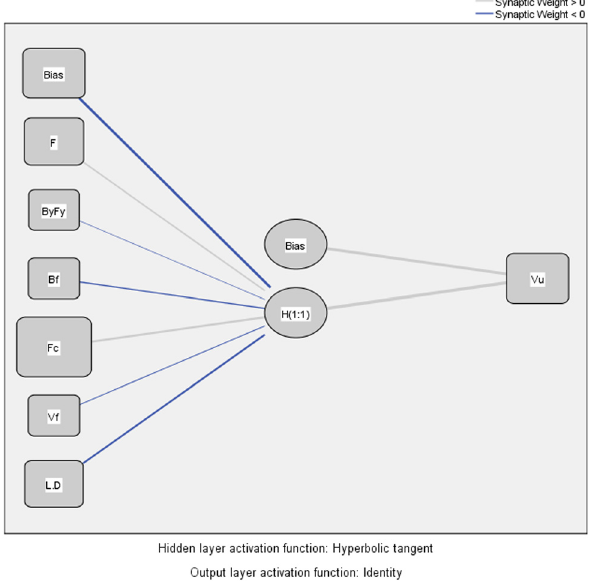
Figure 3: The skeleton of the recent ANN model ( from SPSSV.19 software )